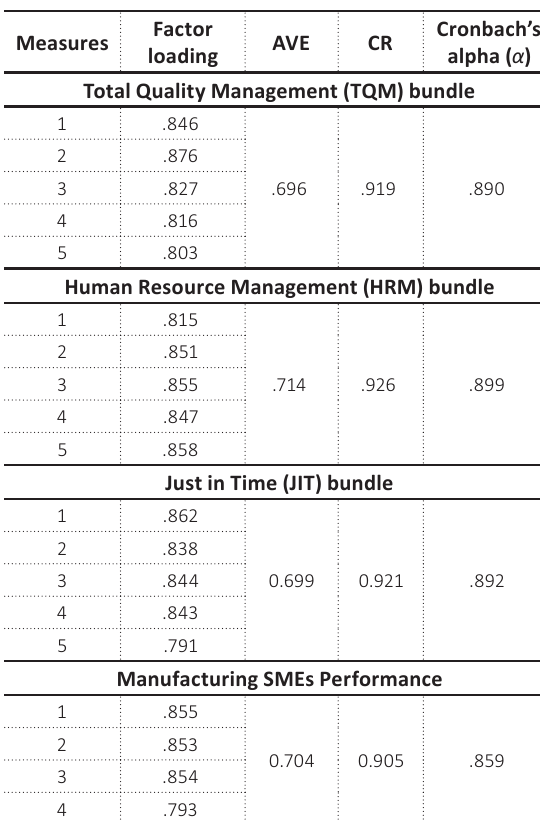
Table 2. Measurement items, validity and reliability